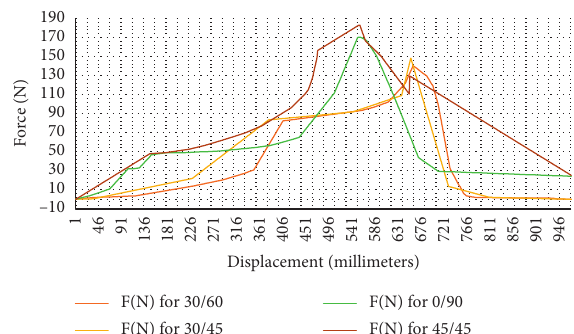
Figure 10: A force versus displacement curve for average data values (imported from Excel sheet).